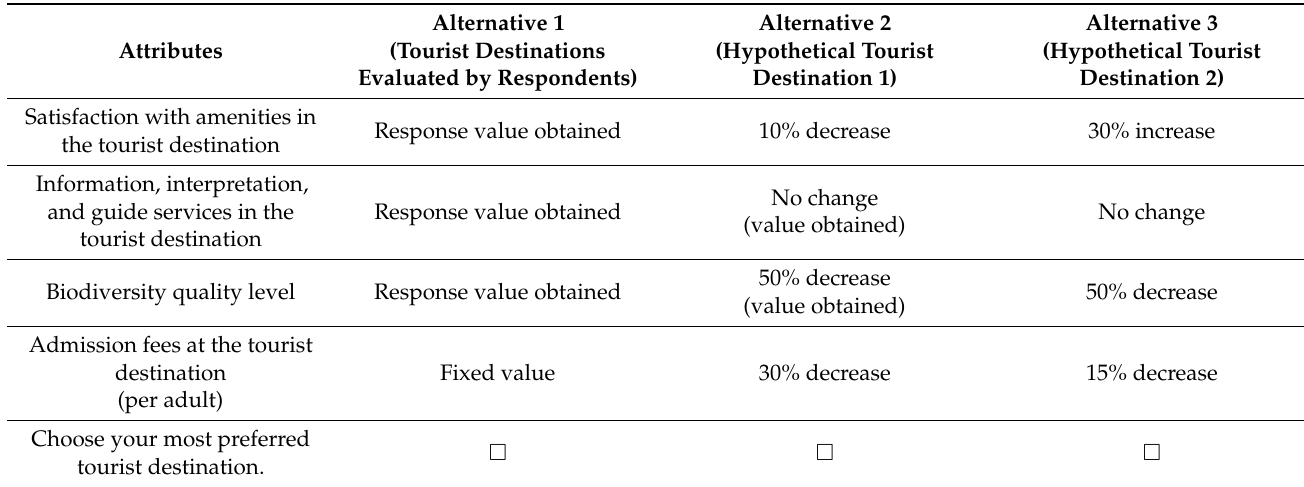
Table 2. Examples of choice alternatives applying a pivot